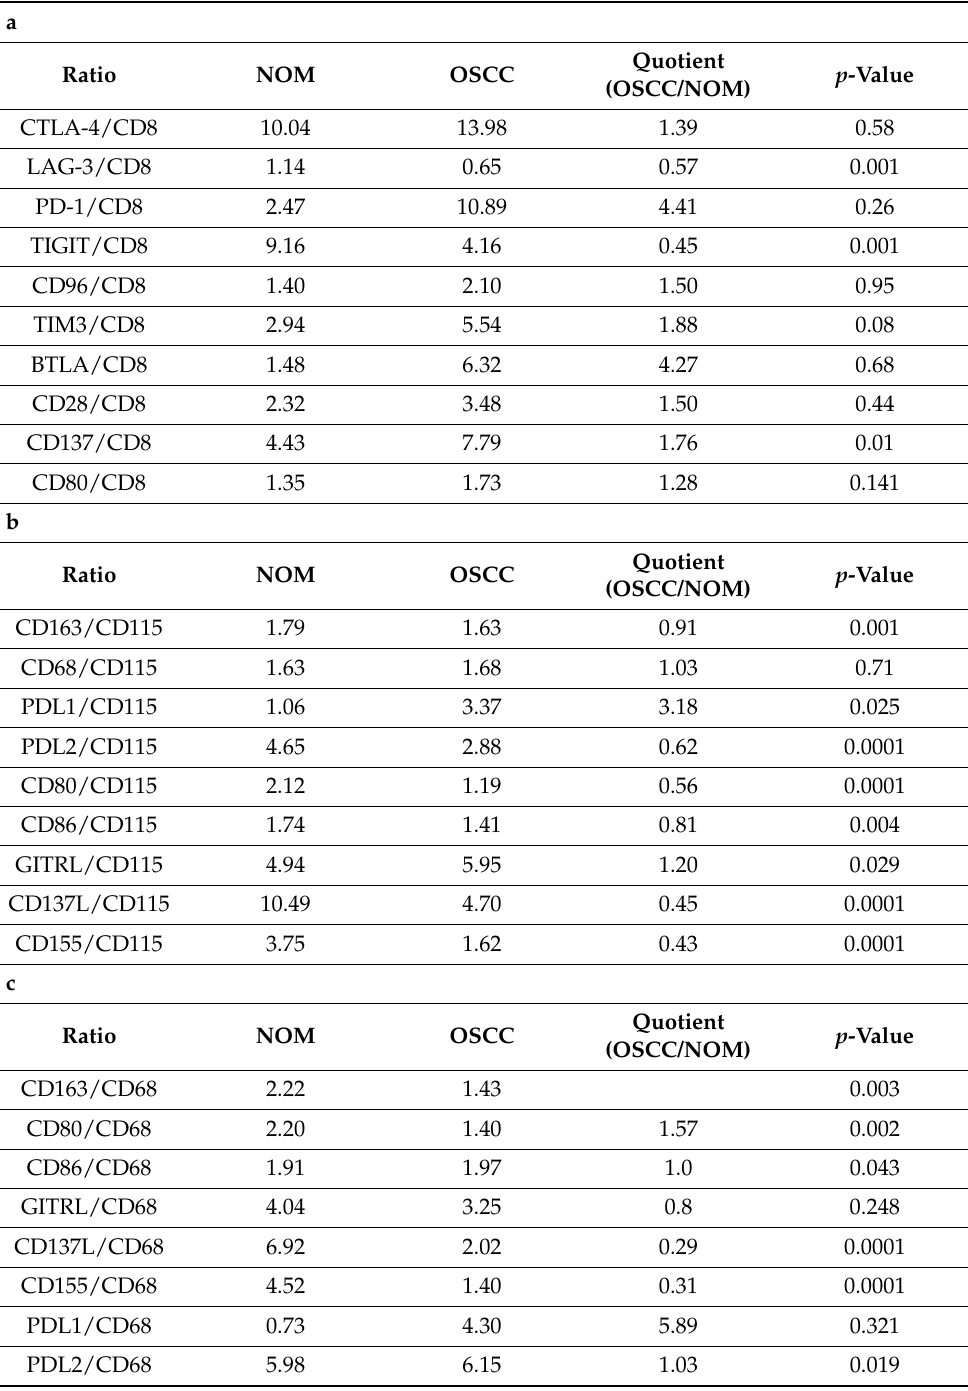
Table 8. Expression of immune-modulatory proteins relative to cellular markers in OSCC and NOM. ( a ) Expression relative to cytotoxic T-cell marker (CD8), ( b ) to the MDSC marker CD115 and ( c ) to macrophage marker CD68. ( d ) CD163 Marker for M2